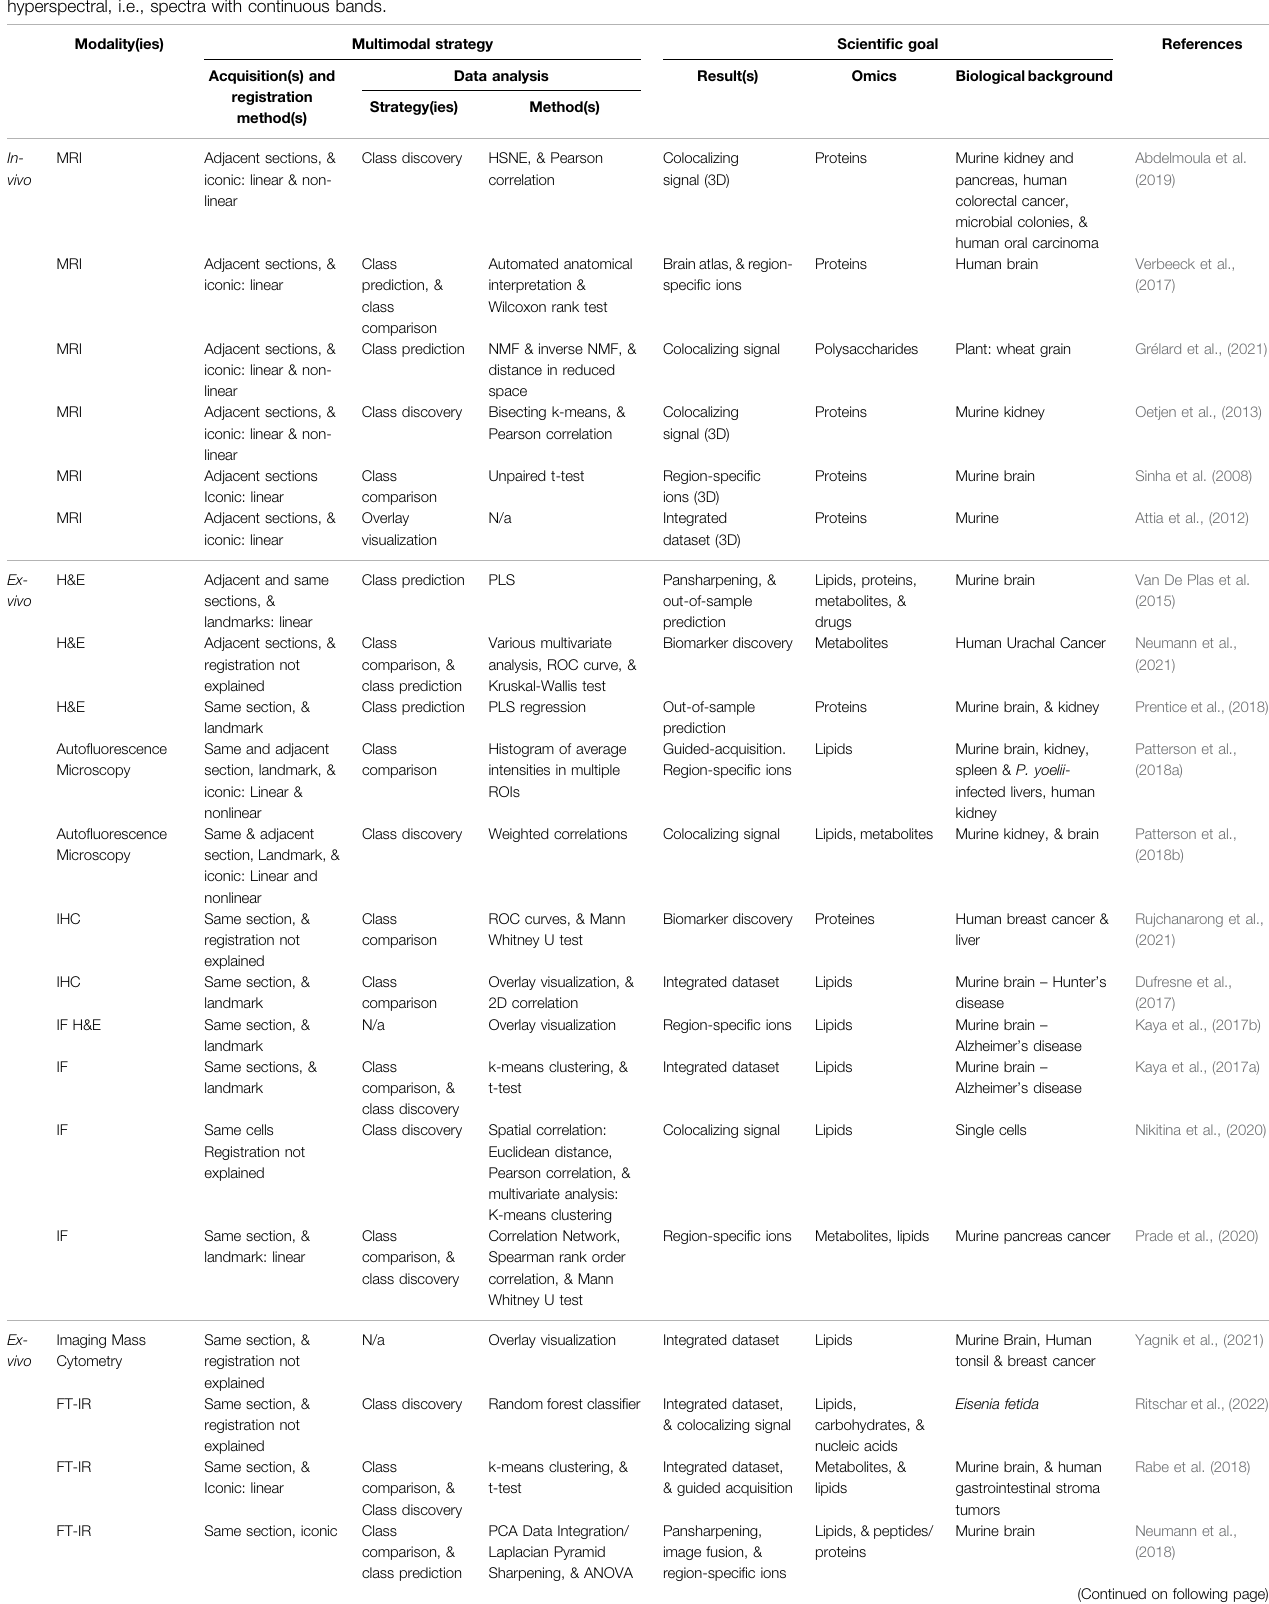
TABLE1| CollectionofpublicationsthatcombineMALDI-MSIwithanothermodality.Itattemptstoclassifyeachpaperbyitsmultimodalstrategyandscienti fi cgoals.Thelist isseparated invivo / exvivo andgroupedbythespectralnatureofitscomplementarymodality,i.e.,whetheritismono-,multi-channel,i.e.,spectrawithdiscretebands,or hyperspectral, i.e., spectra with continuous